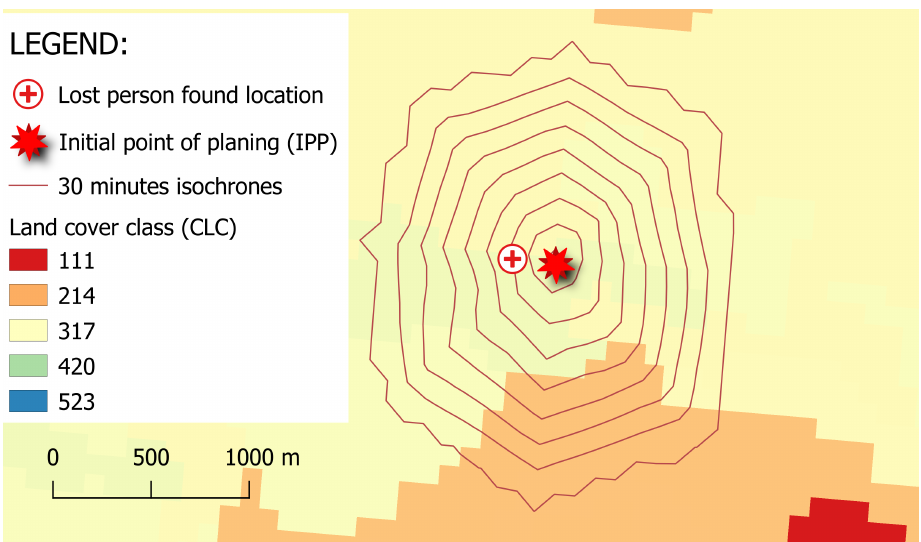
Figure 3. An example of simulation and comparison of lost person end point and distance walked predicted with pre trained model.